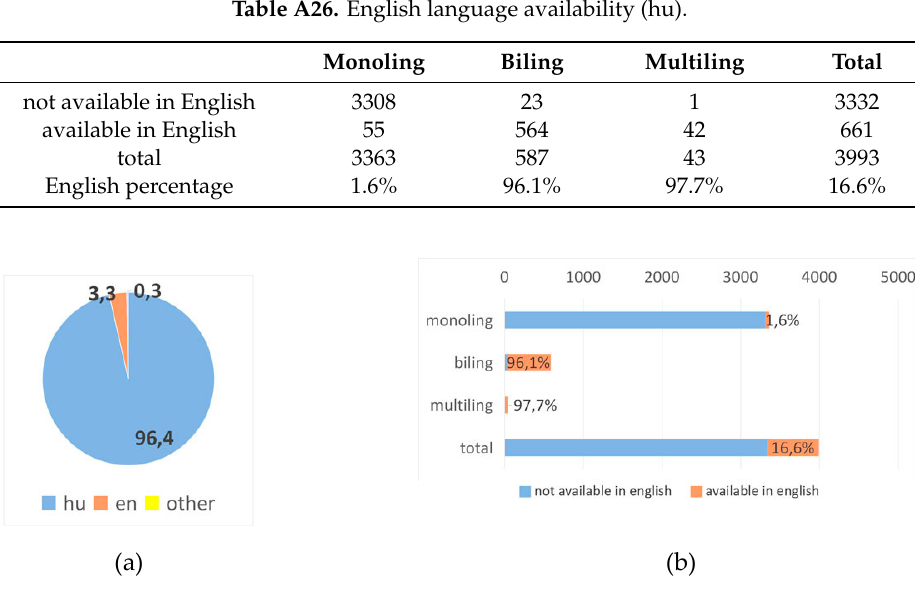
Figure A13. Visualization of the results for domain hu. ( a ) Primary languages pie chart and ( b ) English